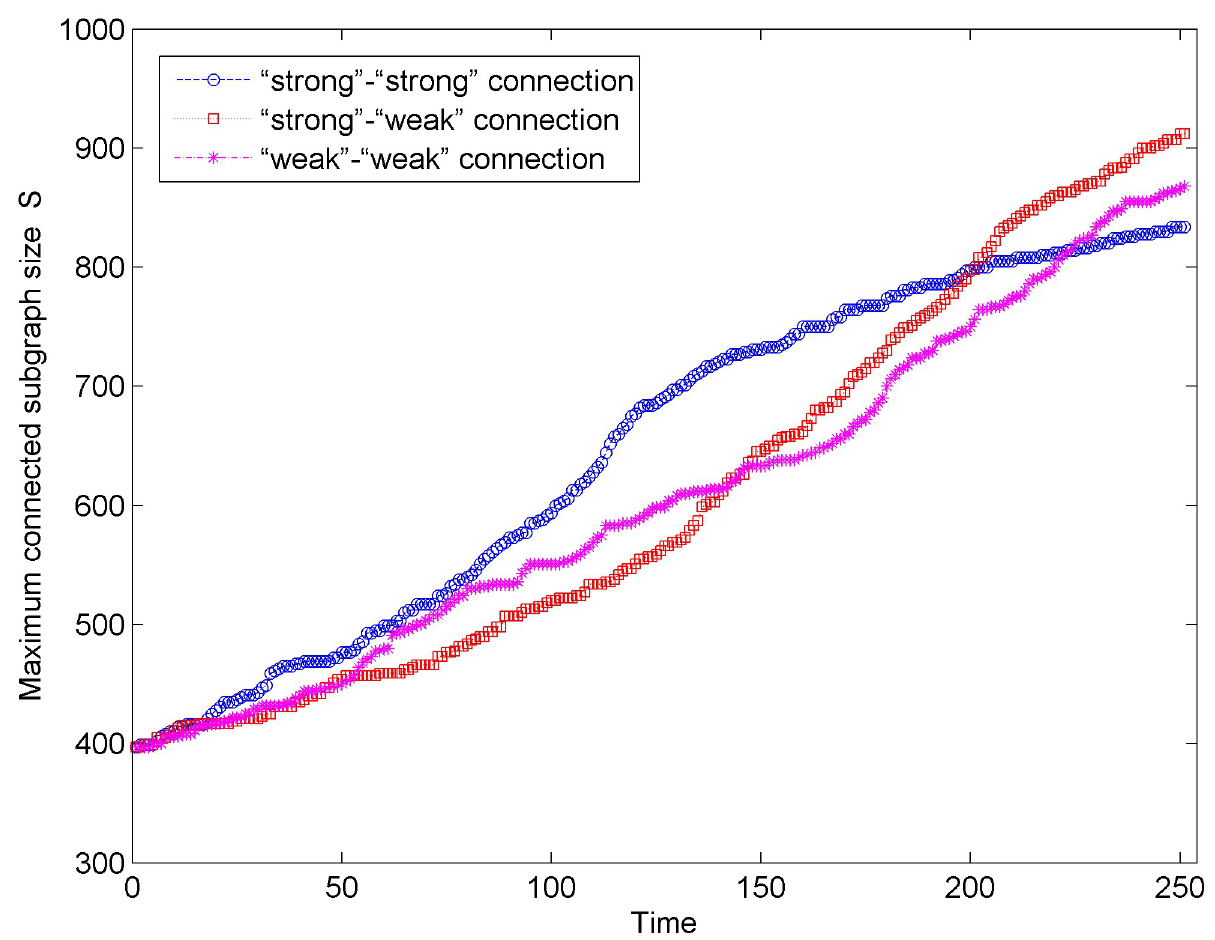
Fig 9. Change of the network performance in the weighted